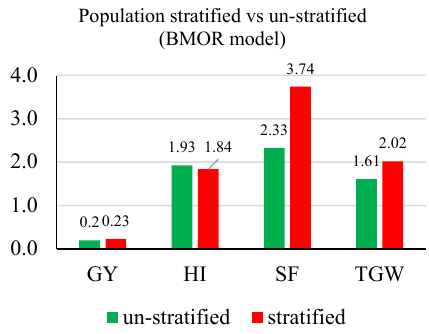
Figure 9. Average response to selection for GY (ton ha − 1 ), HI (%), SF (grains/g chaff weight), and TGW (g) with/without population stratified for five models. GY, grain yield; HI, harvest index; SF, spike fertility; TGW, thousand grain weight. Mean response to selection for each trait were presented and labeled. Stratified scheme was colored in green and un ‐ stratified scheme was colored in red. When applying the BMOR model to predict RTS across environments, the RTS ranged from 0.26 to 0.69 ton ha − 1 for GY, 0.45 to 5.22% for HI, 6.52 to 13.33 grains/g of chaff weight for SF, and 3.03 to 4.36 g for TGW (Figure 10).